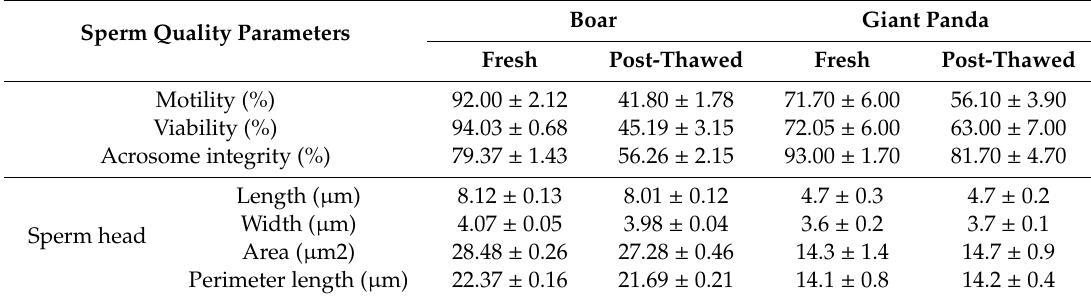
Table 2. Comparison of quality parameters of boar and giant panda sperm before and after cryopreservation. Sperm Quality